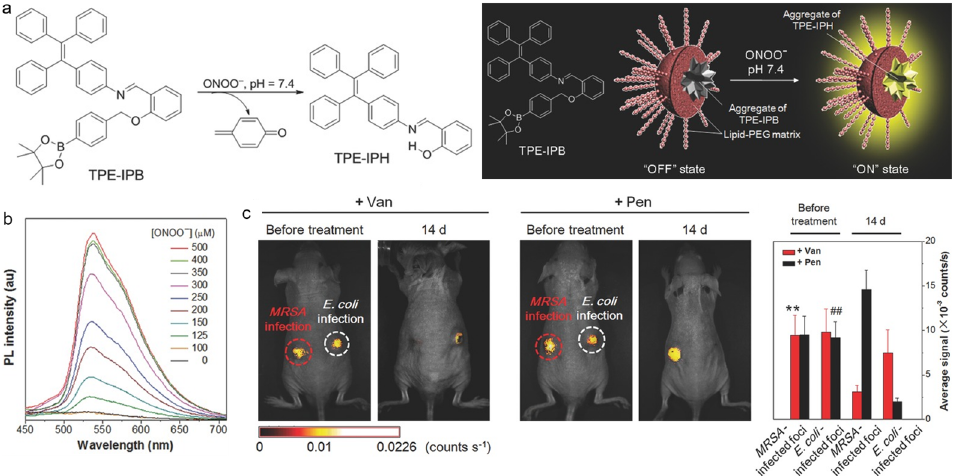
Figure 11. ( a ) TPE-IPB probe for ONOO − detection with turn-on fluorescence; ( b ) PL spectra of TPE-IPB with the treatment of different concentrations of ONOO − ; ( c ) in vivo fluorescence images and the corresponding fluorescence intensity of the mice infected with MRSA at left and E. coli at right before and after vancomycin and penicillin treatment. ** p < 0.01, in comparison between MRSA -infected foci before and after vancomycin treatment for 14 d; ## p < 0.01, in comparison between E. coli -infected foci before and after penicillin treatment for 14 d. (Reproduced with the permission from ref. [146]. Copyright 2016, WILEY-VCH Verlag GmbH & Co. KGaA, Weinheim).